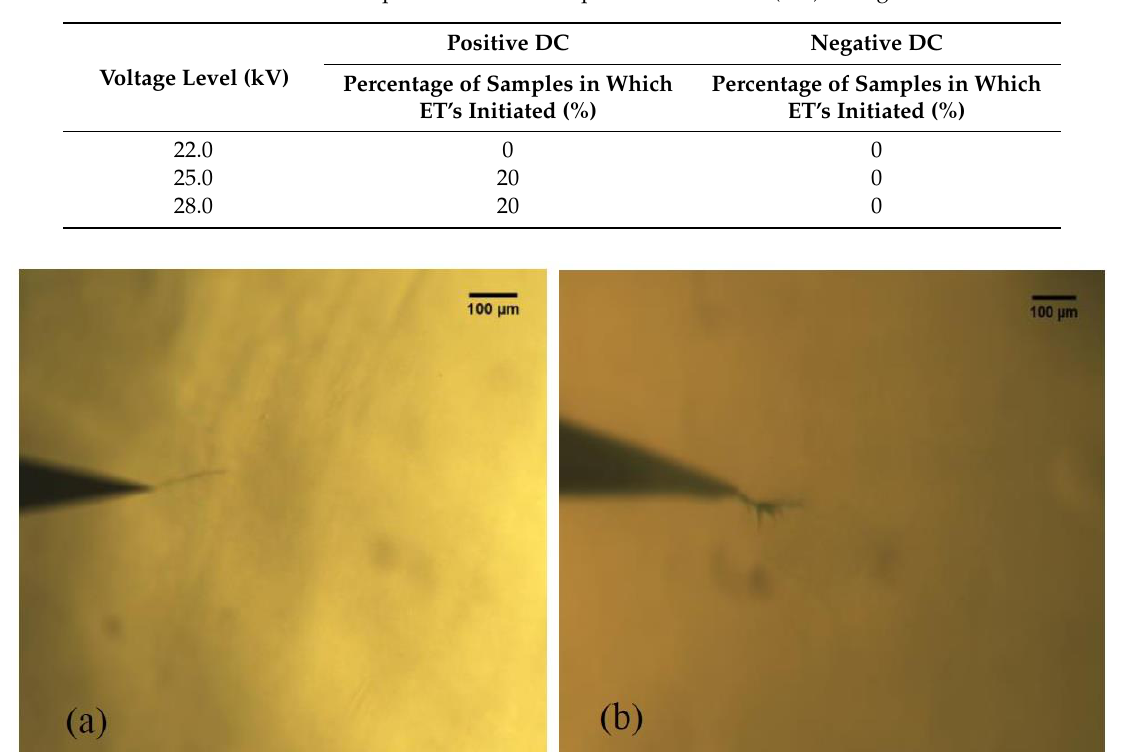
Table 1. Tree inception at continuous pure direct current (DC) voltages.